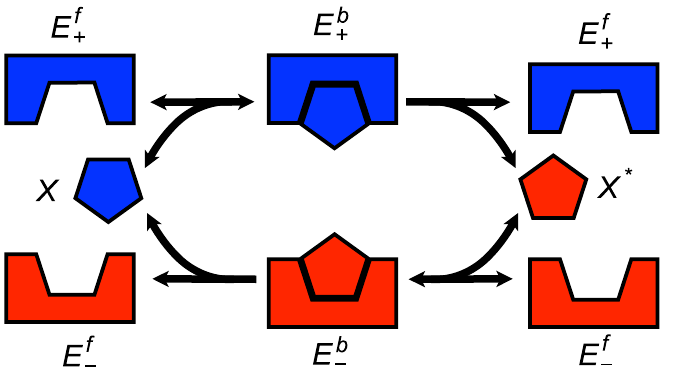
Figure 6. Enzymatic futile cycle. X is transformed into X (cid:3) and vice versa by enzymes E z and E { , respectively.